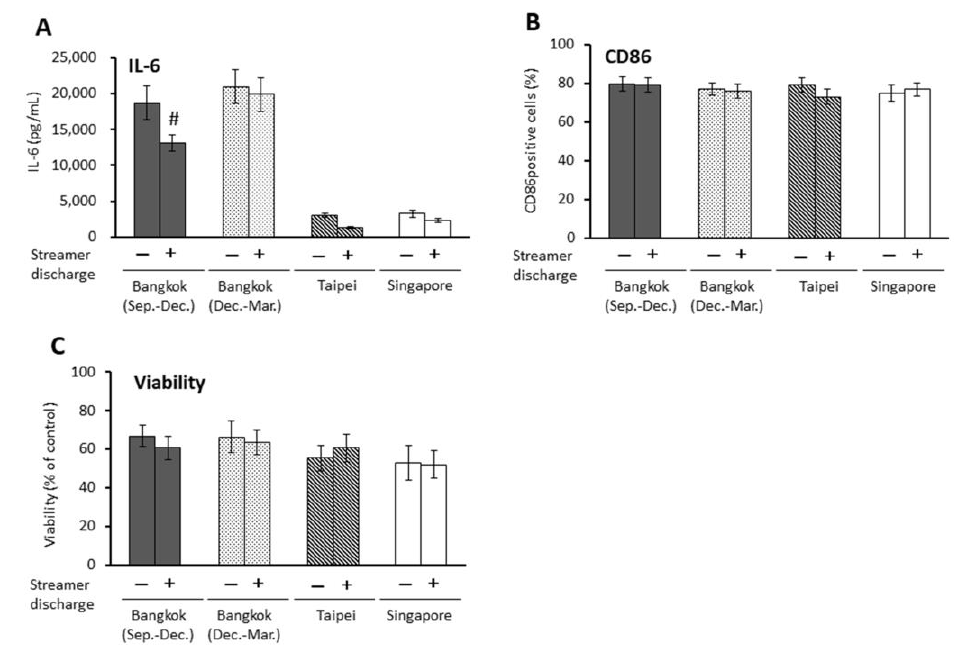
Figure 4. Effects of streamer-discharged PM2.5 at a dose of 75 µ g/mL on proinflammatory responses, CD86 expression, and viability in antigen-presenting cells (APCs). ( A ) IL-6 release, ( B ) CD86 positive cells, ( C ) cell viability. # p < 0.05 vs. non-treated PM2.5.